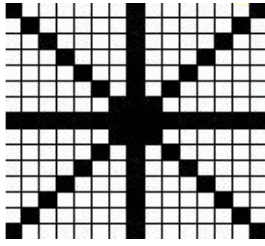
Figure 5. Scheme of used pixels in the local sliding window.